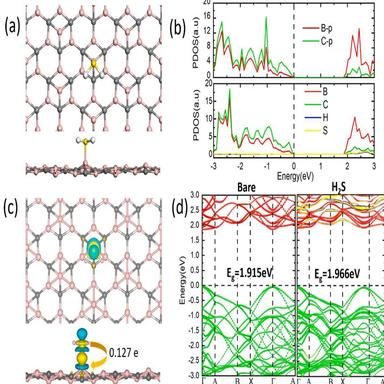
(a) Top and side views of the H2S adsorbed electronic structure. (b) The density of state before and after the adsorption. (c) The differential charge density of H2S/B4C3 configuration. (d) Band structure of pristine and H2S-adsorbed B4C3.